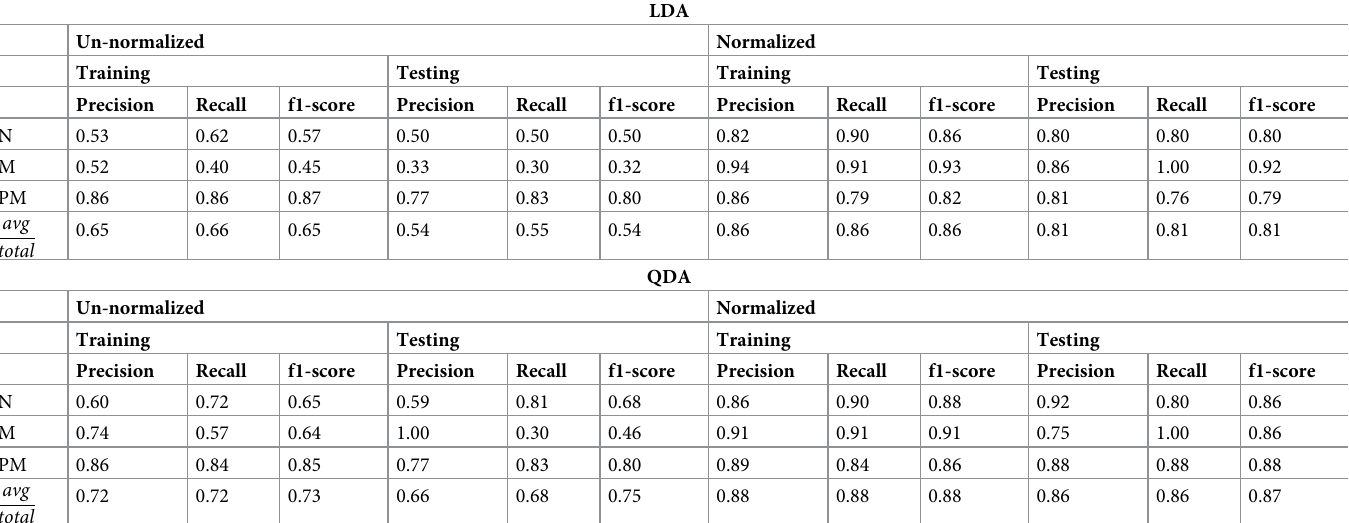
Table 4. Performance table of LDA and QDA for